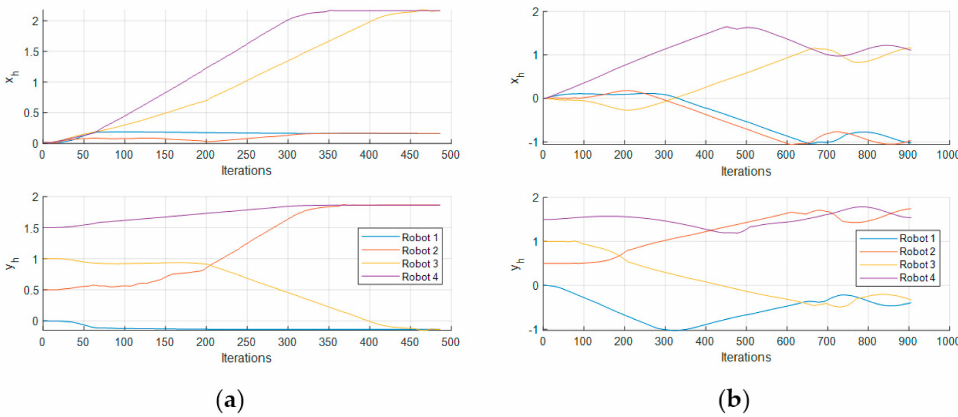
Figure 25. Trajectories along iterations in the comparison tests with collision avoidance but without an end point reference: ( a ) Scheme proposed in this paper; ( b ) scheme proposed in